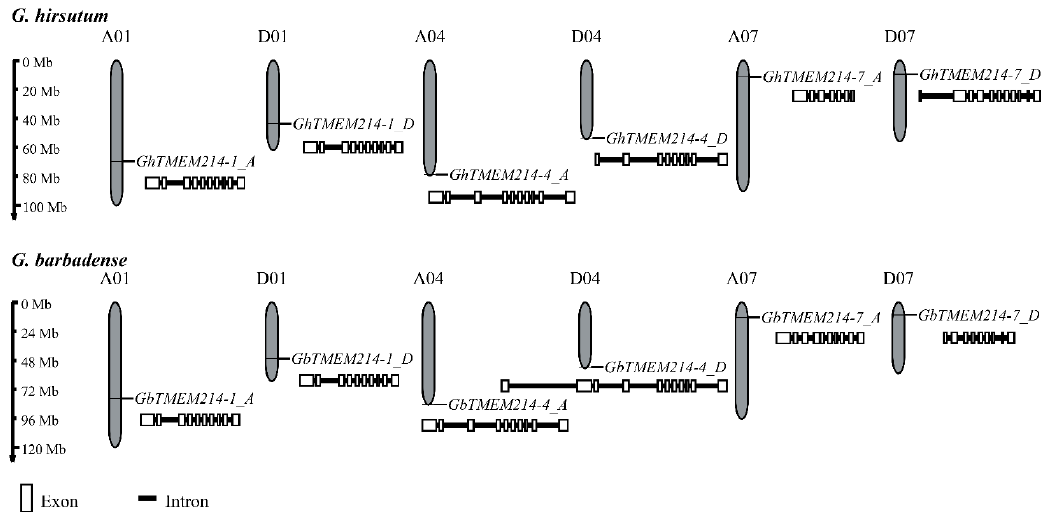
Figure 1. The position of TMEM214 genes in the chromosomes of G. barbadense and G. hirsutum. The TMEM214 genes in cotton were predicted with the hidden Markov model (HMM) and HMMER 3.0 software with the HMM seed file of TMEM214 (PF10151). GbTMEM214s and GhTMEM214s were named according to their localization on the chromosomes of G. barbadense and G. hirsutum , respectively. The gene structure was analyzed with GSDS 2.0 (http://gsds.cbi.pku.edu.cn/ accessed on 13 May 2022). The exons were boxed and the introns were lined.